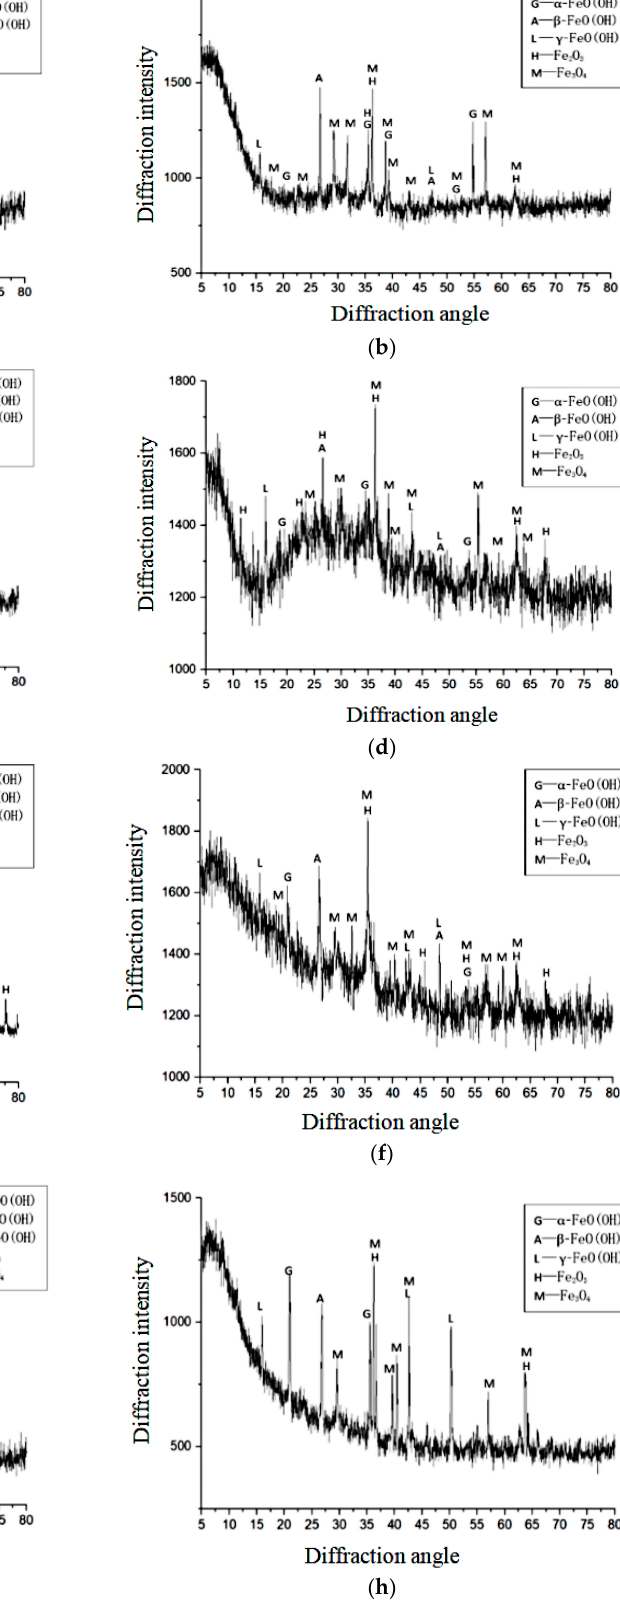
Figure 14. X-ray diffraction results of the corrosion products in different specimens. ( a ) X-ray diffraction pattern ( d = 10 mm, l = 32 mm, dry:wet = 12:12), ( b ) X-ray diffraction pattern ( d = 10 mm: l = 32 mm, dry:wet = 8:16), ( c ) X-ray diffraction pattern ( d = 8 mm, l = 32 mm, dry:wet = 12:12), ( d ) X-ray diffraction pattern ( d = 8 mm, l = 40 mm, dry:wet = 8:16), ( e ) X-ray diffraction pattern ( d = 8 mm, l = 32 mm, dry:wet = 8:16), ( f ) X-ray diffraction pattern ( d = 8 mm, l = 40 mm, dry:wet = 4:20), ( g ) X-ray diffraction pattern ( d = 10 mm, l = 40 mm, dry:wet = 8:16), ( h ) X-ray diffraction pattern ( d = 10 mm, l = 40 mm, dry:wet = 4:20).